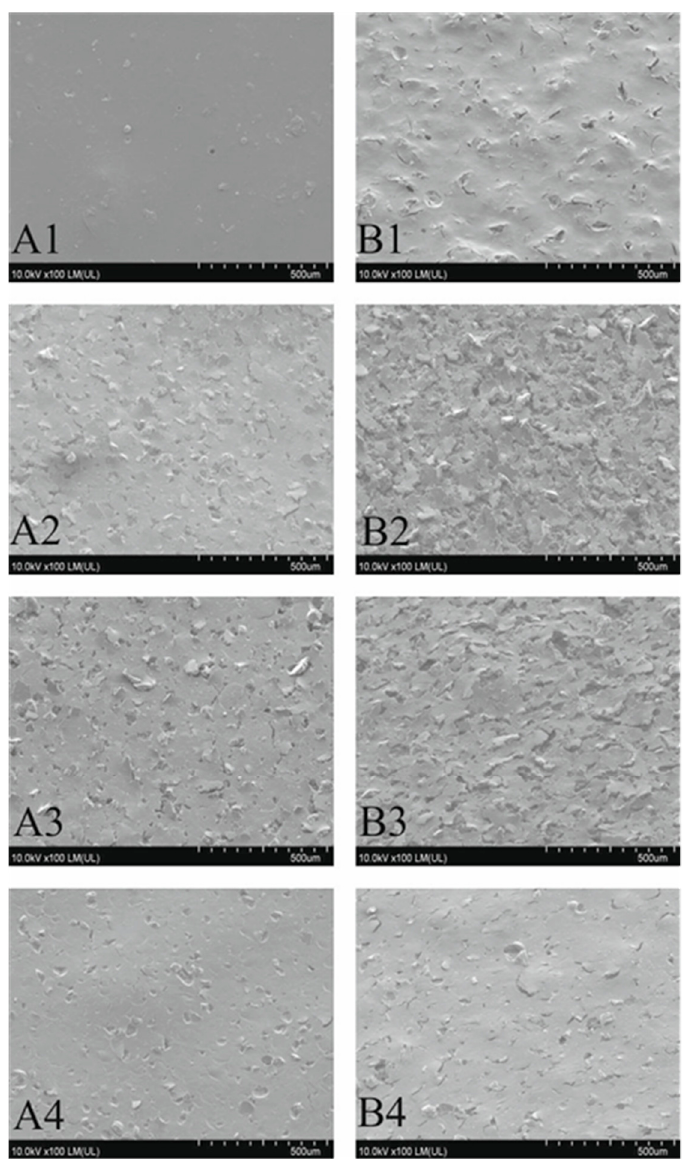
Figure 5. SEM images of laser irradiated coatings (coatings designation in Table 1). The smallest changes in the structure are visible on the A1 and B1 coatings. The higher the Sb 2 O 3 content in the coatings, the more diverse is the topography of the irradiated coat- ings. The most changed surface can be observed for the B2 and B3 coatings, where Sb 2 O 3 content is the highest. In addition, in the case of coatings with a high content of Sb 2 O 3 , the difference in the effects of laser irradiation between coatings with compounds A or B is clearly visible. Laser radiation caused much greater changes on the surface of coatings containing compound B. The reason for this can be the significant lylower degradation temperature of the compound B, which was determined based on TG